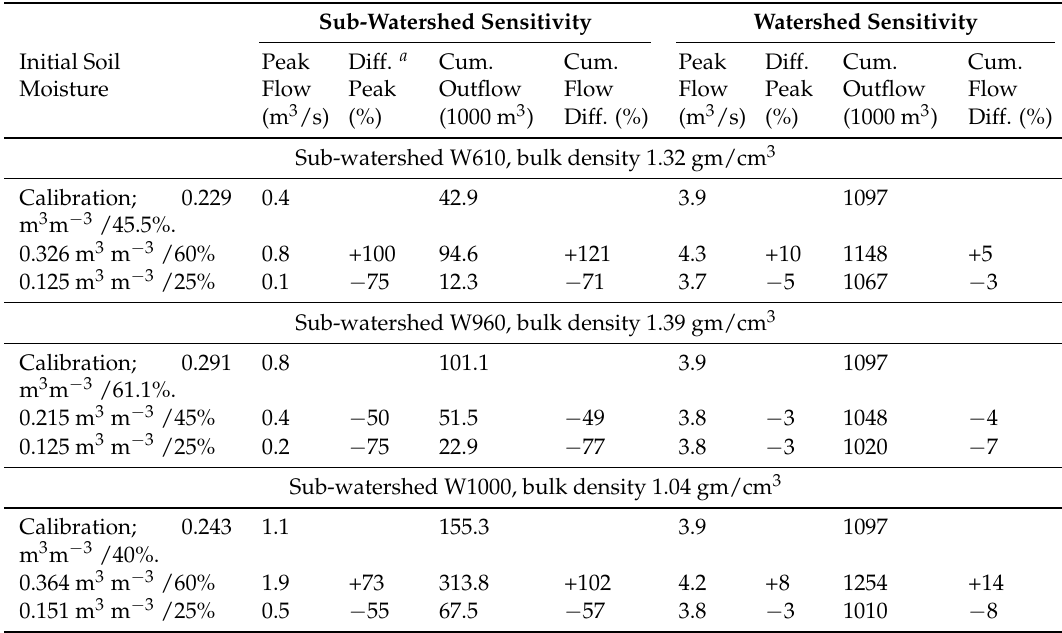
Table 5. Sensitivity of peak flow (m 3 /s) and cumulative flow (1000 m 3 ) at different initial soil moistures. Results from three sub-watersheds (W610, W690, and W1000) are shown. Sub-Watershed Sensitivity Watershed Sensitivity Initial Soil Peak Diff. a Cum. Cum. Peak Diff. Cum. Cum. Moisture Flow Peak Outflow Flow Flow Peak